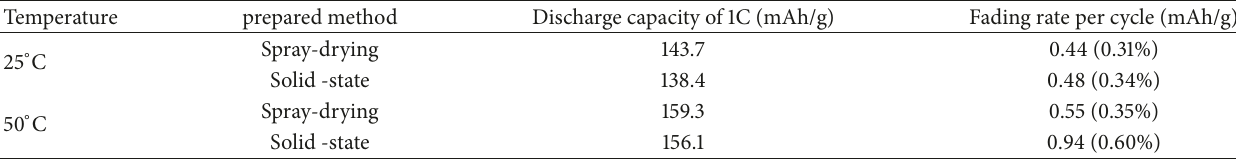
Table 1: Discharge capacity and fade rate of samples operated at different temperatures [30].